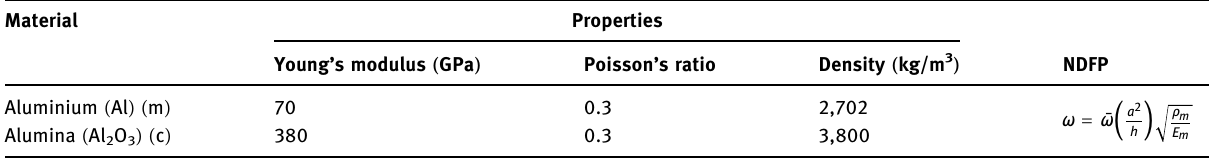
Table 1: Various material properties